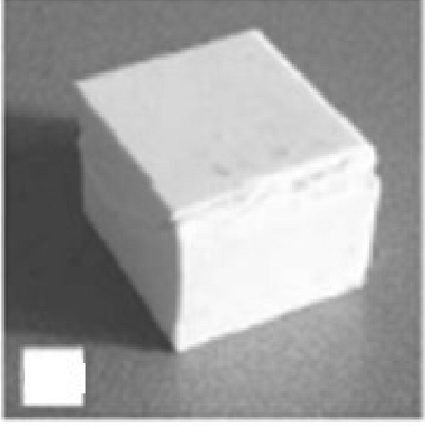
Figure 2. EPP specimen in quasi-static tests.